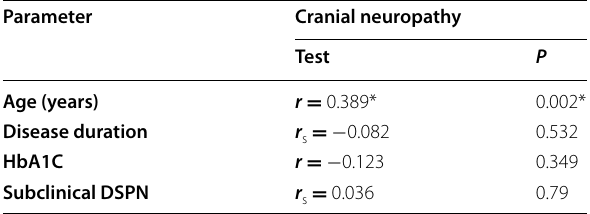
Table 6 Correlation between age, disease duration, the HbA1C level, and subclinical DSPN with cranial neuropathy in the diabetic